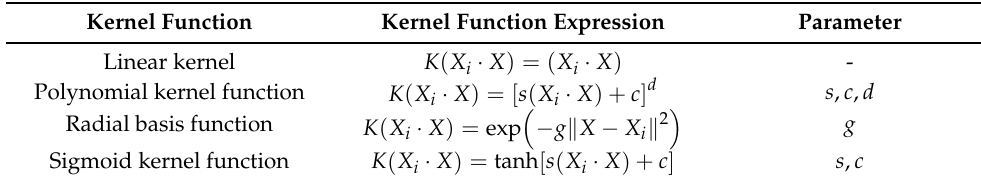
Table 2. Common kernel functions in